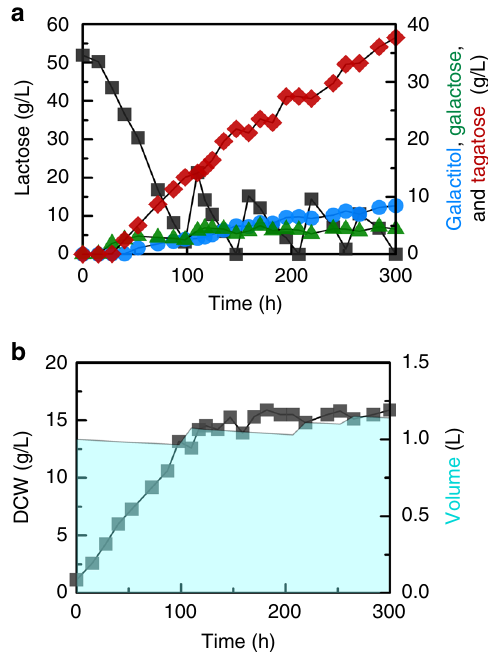
Fig. 5 Tagatose production by the EJ2g_iXiG_pXpG strain in a 2 L bioreactor. a Pro fi les of lactose, galactose, galactitol, and tagatose concentrations, and b the growth of the EJ2g_iXiG_pXpG strain and the volume changes of bioreactor during the fed-batch fermentation. Source